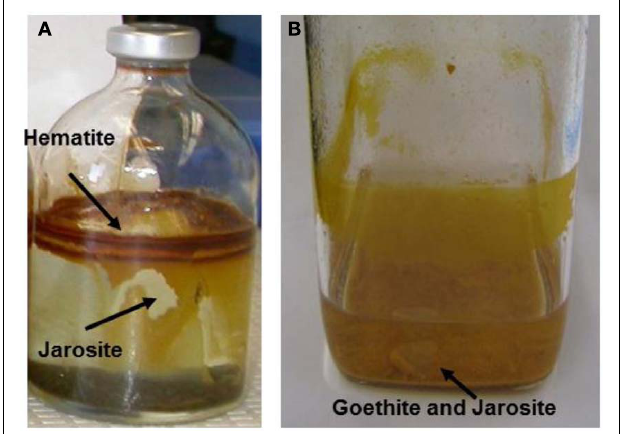
FIGURE 9 | Serum bottle culture of (A) Metallosphaera yellowstonensis str. MK1 and (B) Sulfolobales str. MK5 showing location of secondary phases sampled for solid phase analysis (11days incubation, pyrite used as the electron donor).